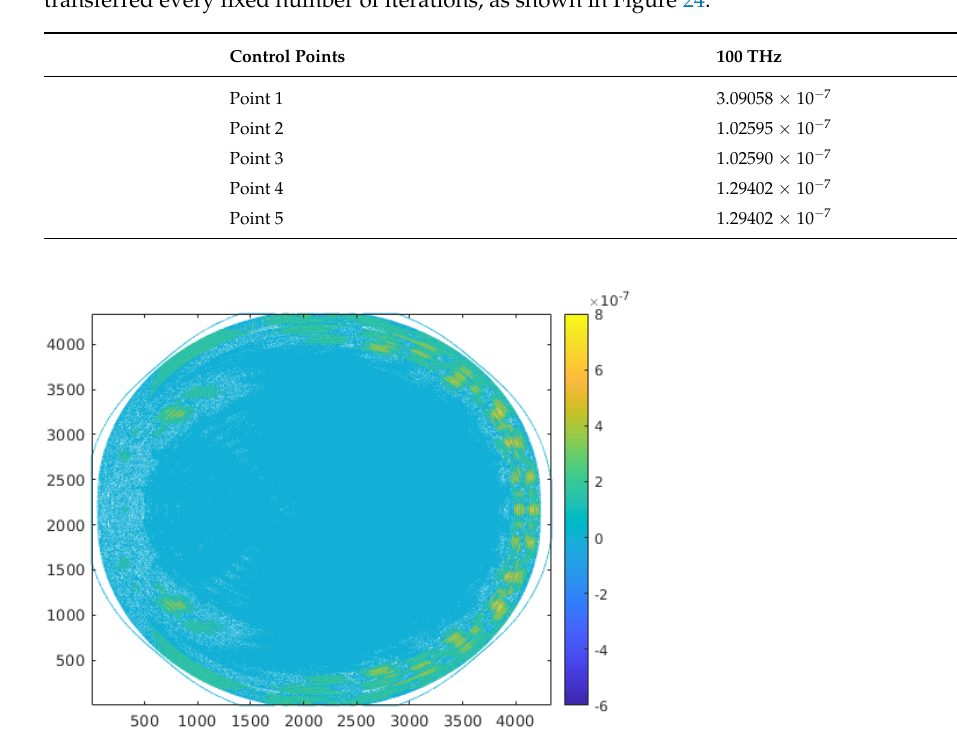
Table 20. MSE for each control point compared with the reference solution (CPU double precision) versus the solution obtained in the GPUs at 100 THz. The values used for the error calculation are transferred every fixed number of iterations, as shown in Figure 24.